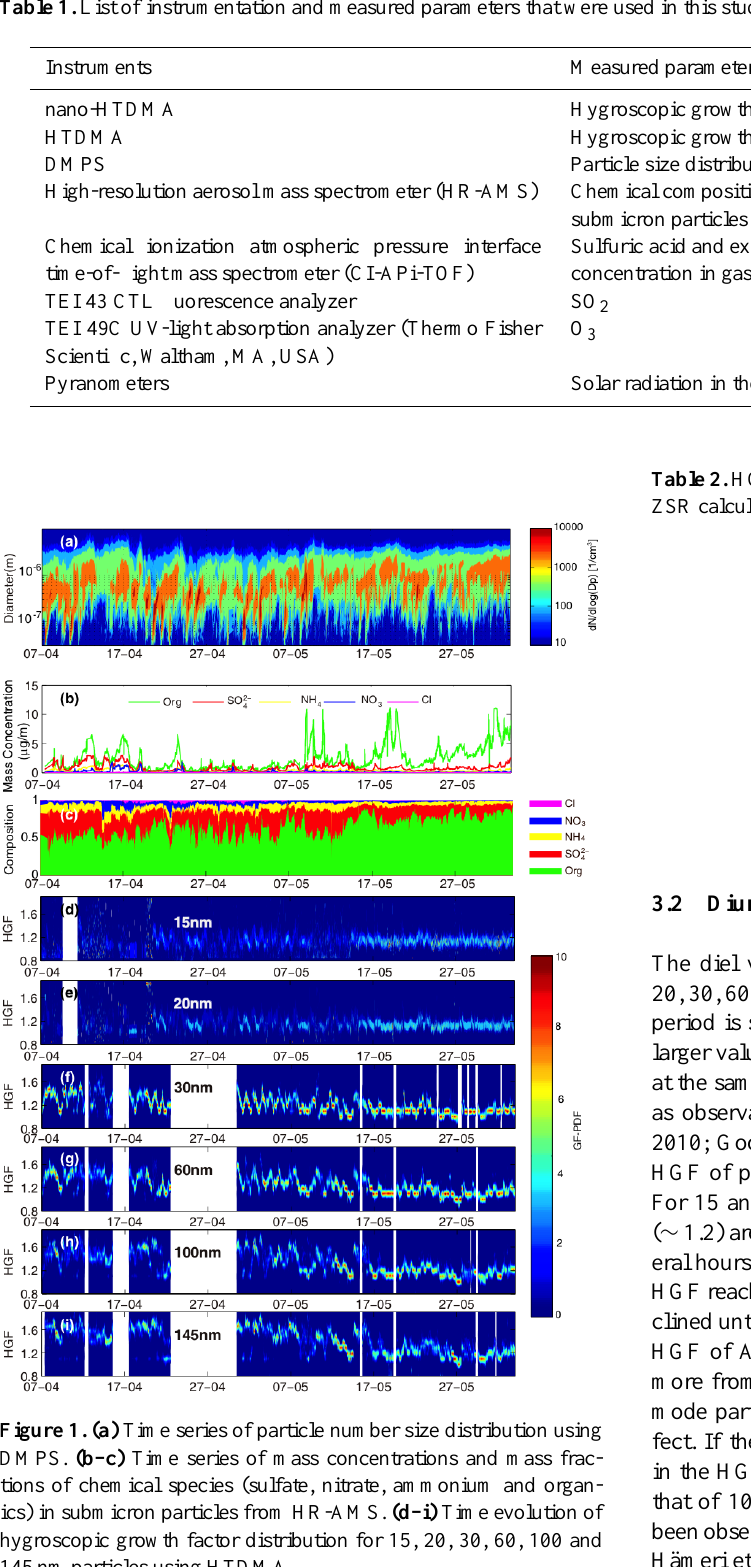
Table 1. List of instrumentation and measured parameters that were used in this study.